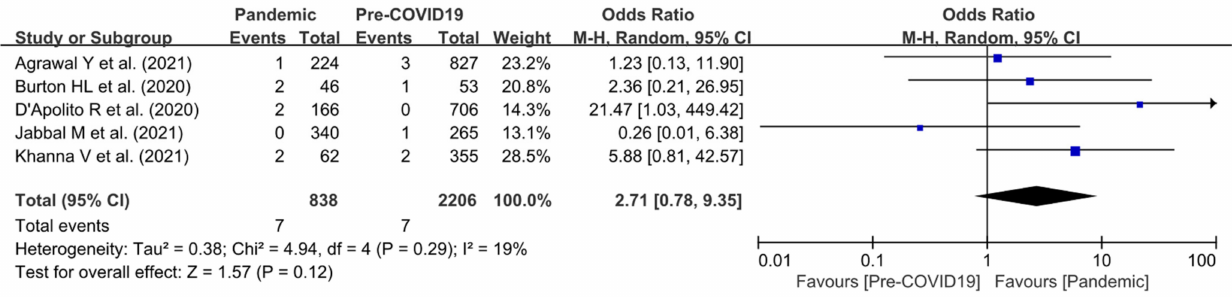
Figure 2. Forest plot comparing overall mortality of patients following hip or knee arthroplasty between the pandemic and pre-pandemic